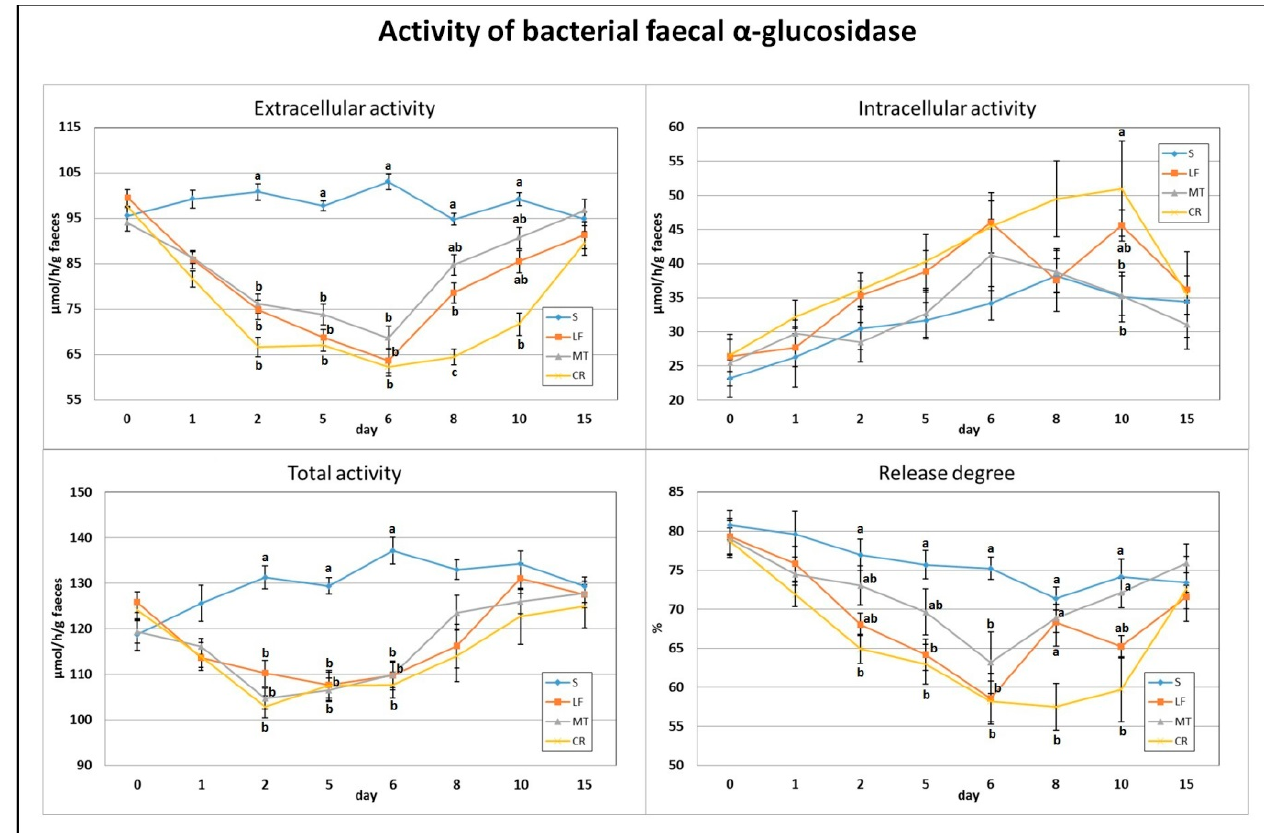
Figure 3. Experimental factor in particular groups: S—control standard diet (0–15 days); LF—standard diet with lactoferrin addition 100 mg/kg (0–5 days diet LF and 6–15 days diet S); MT—standard diet with melittin addition 100 mg/kg (0–5 days diet MT and 6–15 days diet S); CR—standard diet with cecropin A addition 100 mg/kg (0–5 days diet CR and 6–15 days diet S). a,b,c Mean values on the day with no common superscript are different at p ≤ 0.05. Data are presented as the mean with SEM; SEM—SD for all rats divided by the square root of rat number in one group ( n = 8). Release degree, extracellular expressed as percent of total activity.